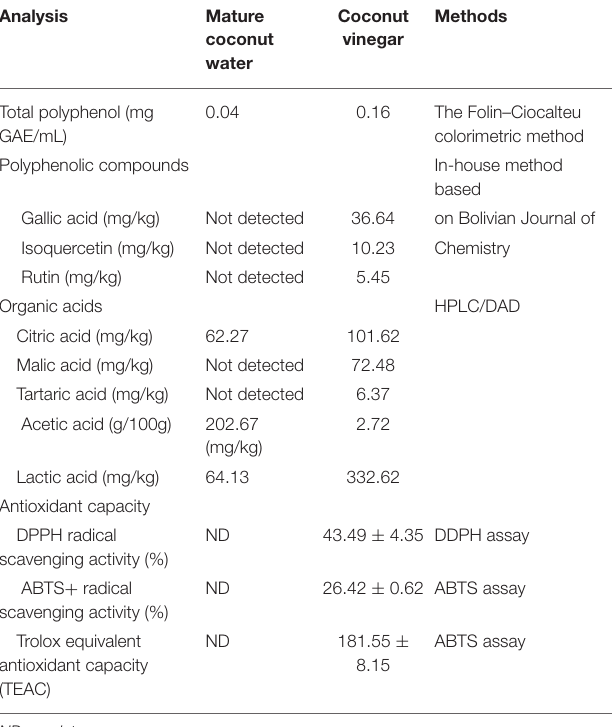
TABLE 1 | Bioactive compounds and antioxidant